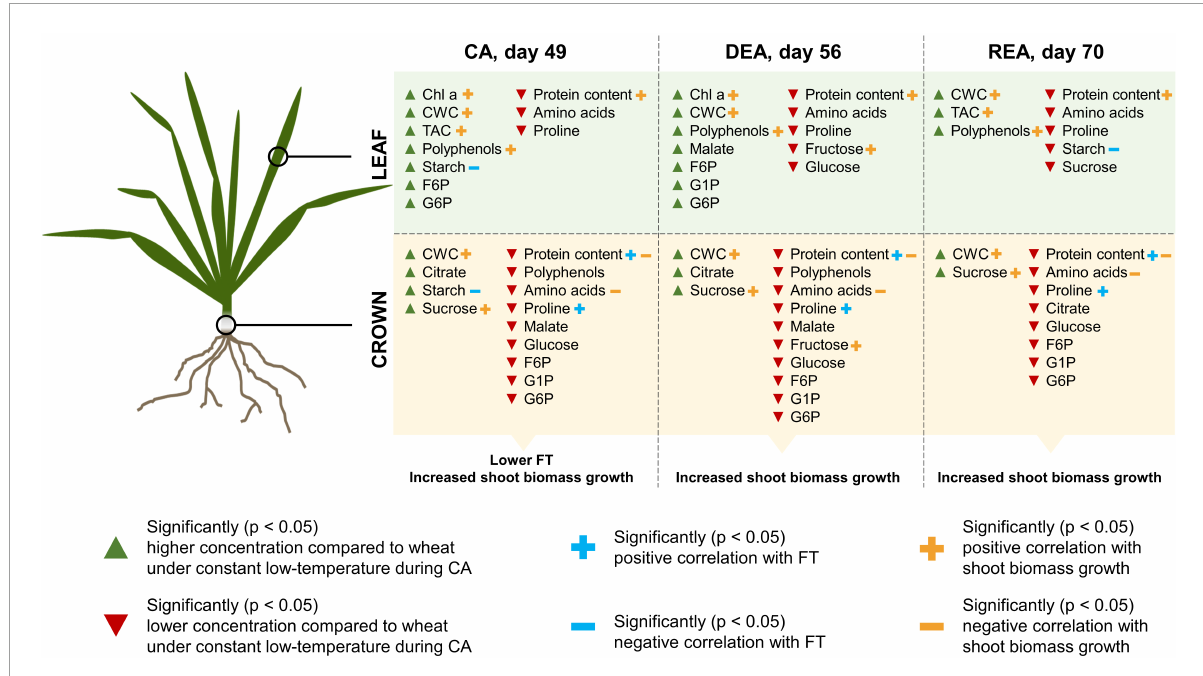
FIGURE6 The effect of prolonged higher low-temperature treatment on winter wheat metabolite concentrations and physiology throughout CA, DEA, and REA, as compared to constant low-temperature treatment. Only statistically significant ( p < 0.05) changes are depicted.